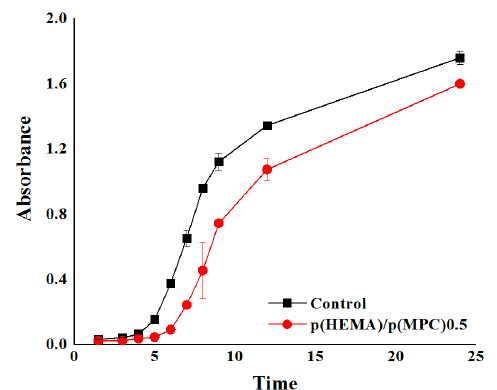
Figure 4. Bacterial adsorption profiles of the poly(2 ‐ methacryloyloxyethyl phosphorylcholine) ‐ surface ‐ functionalized hydrogels. functionalized